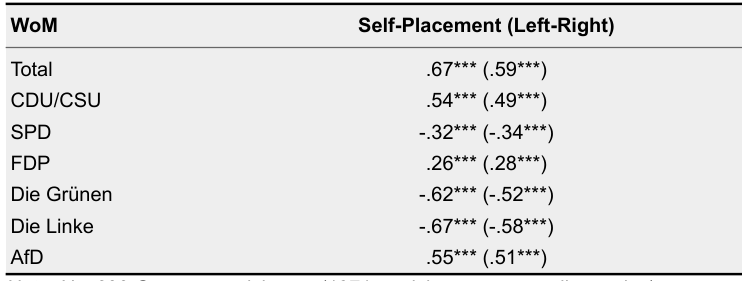
Note. N = 699 German participants (1371 participants across all